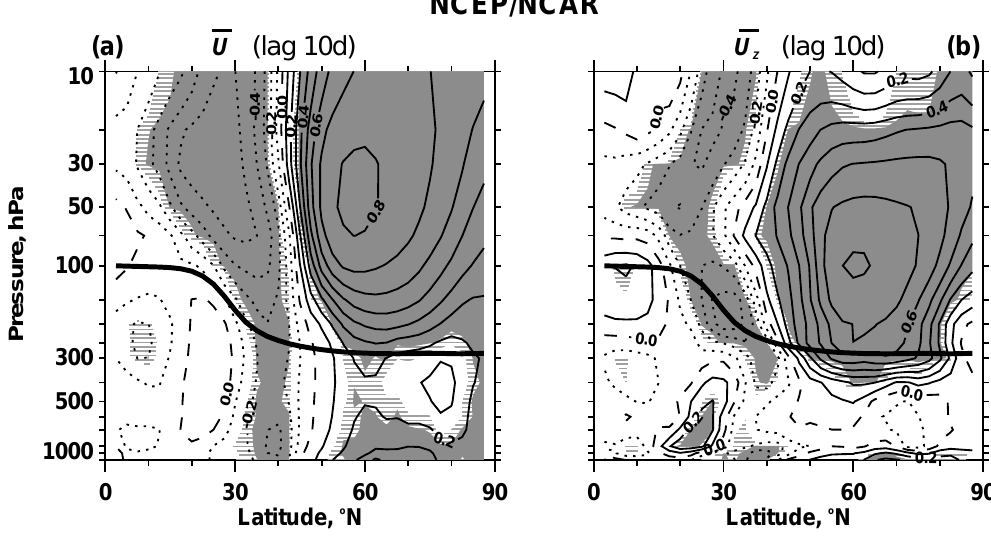
Fig. 9. Cross correlation of the 60-day low-passed NAM index at 20hPa with the 60-day low-passed anomalies of (a) zonal mean zonal wind and (b) zonal mean zonal wind shear at lag 10 days. Contours and shading as in Fig. 2. The NCEP-NCAR reanalysis.